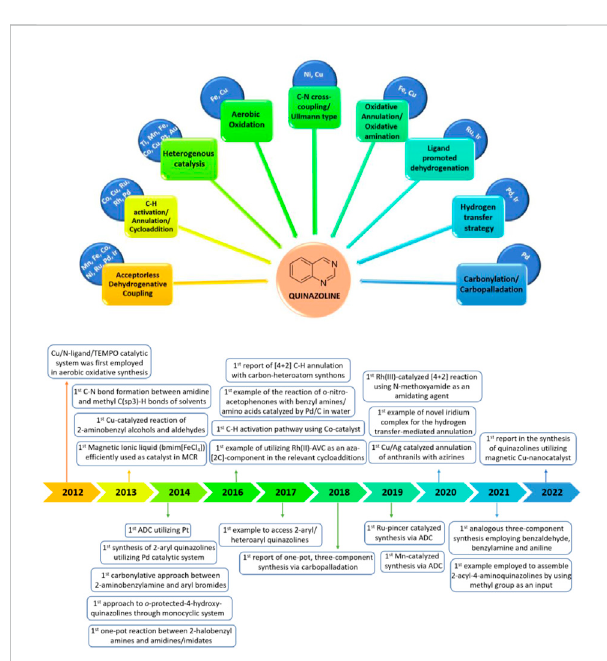
First-, second-, and third-row transition-metal-catalyzed synthesis of quinazolines and fi rst reported examples involved in the synthesis of quinazolines (2012 –